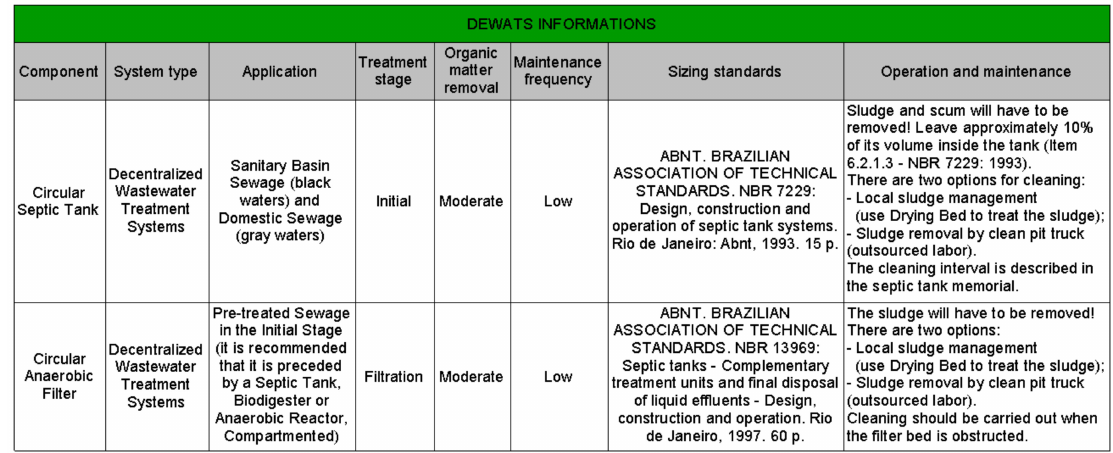
Figure 3. Automatically generated table of information about the DEWATS used in the projects. Source: authors